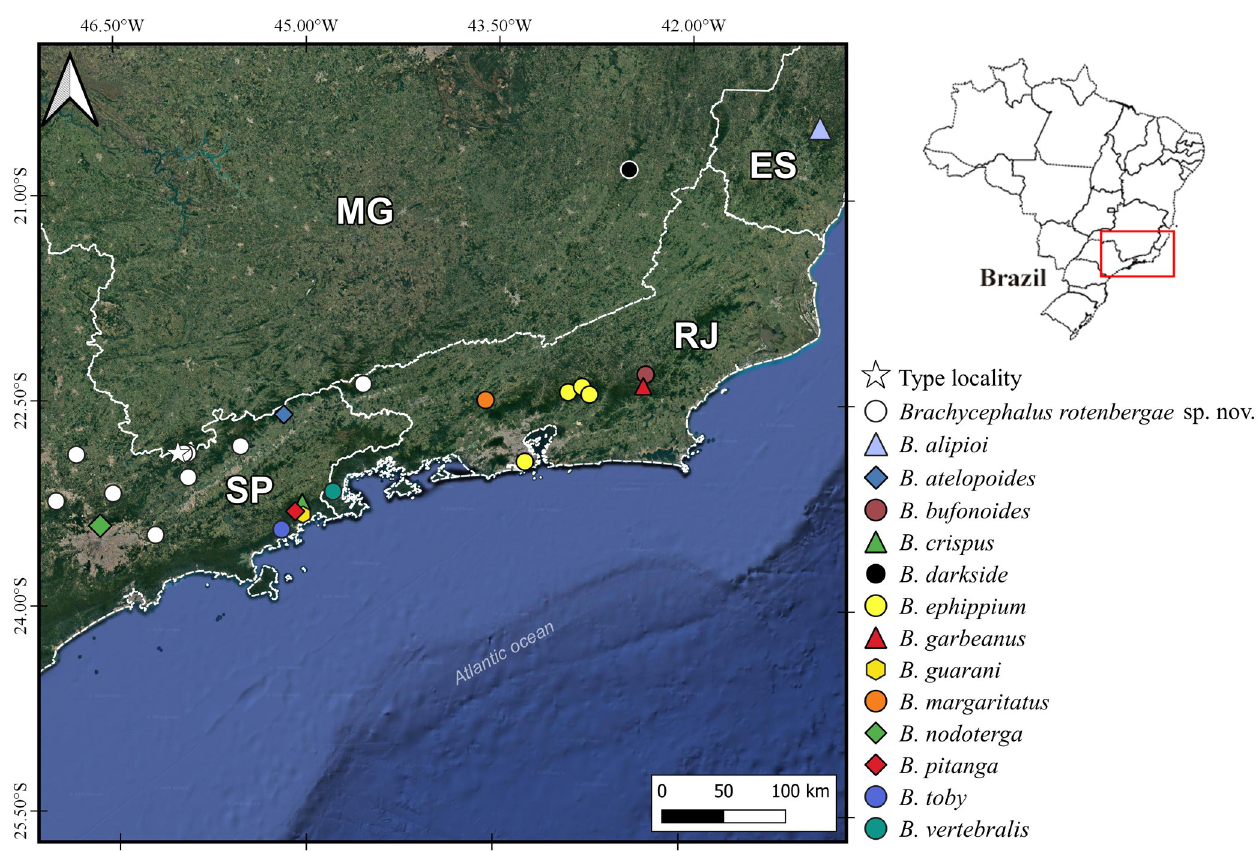
Fig 7. Geographic distribution map for the species of Brachycephalus ephippium group on Google satellite map. See the species records on S3 Table. Star = type locality of B . rotenbergae sp. nov. ES = state of Espı´rito Santo, MG = state of Minas Gerais, RJ = state of Rio de Janeiro, SP = state of S ã o Paulo.